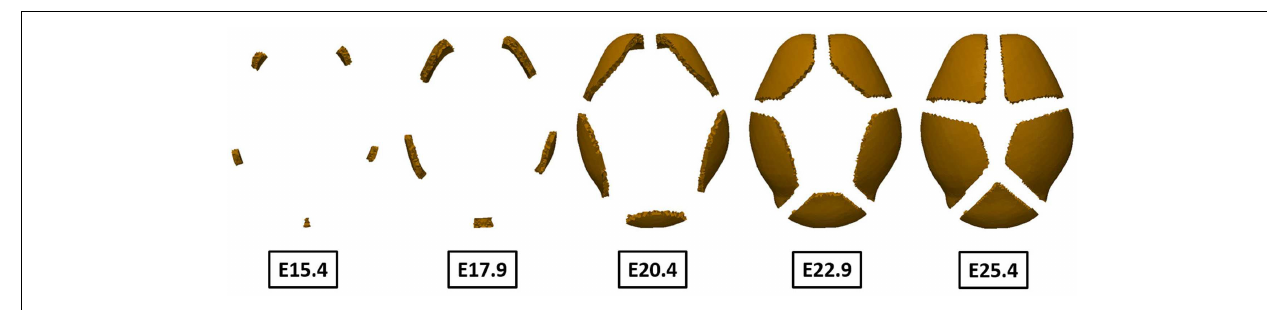
within mineralized bone, it can be said to show pattern of bone growth.The results agree well with experimental observation showing two frontal bones, two parietal bones, and one interparietal bone. Sutures form between bones as bones grow according to repulsive effect between bones in our